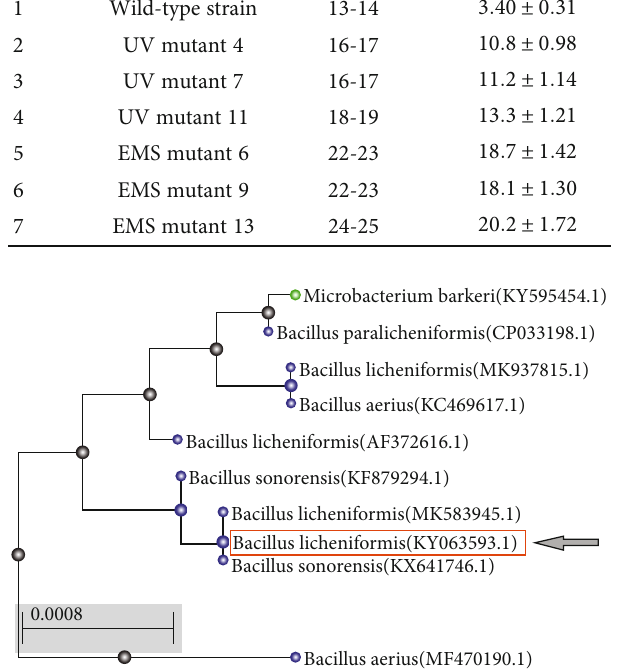
Figure 4: Phylogenetic tree of the selected strain Bacillus licheniformis SSCL-10 from other bacterial taxa.